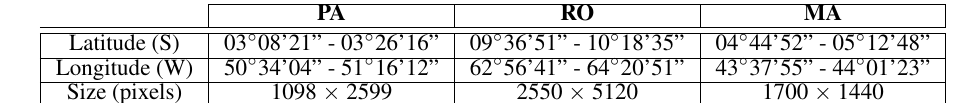
Figure 3. Study areas on Brazilian Biomes; the images are those of the second acquisition epoch in all three test areas.